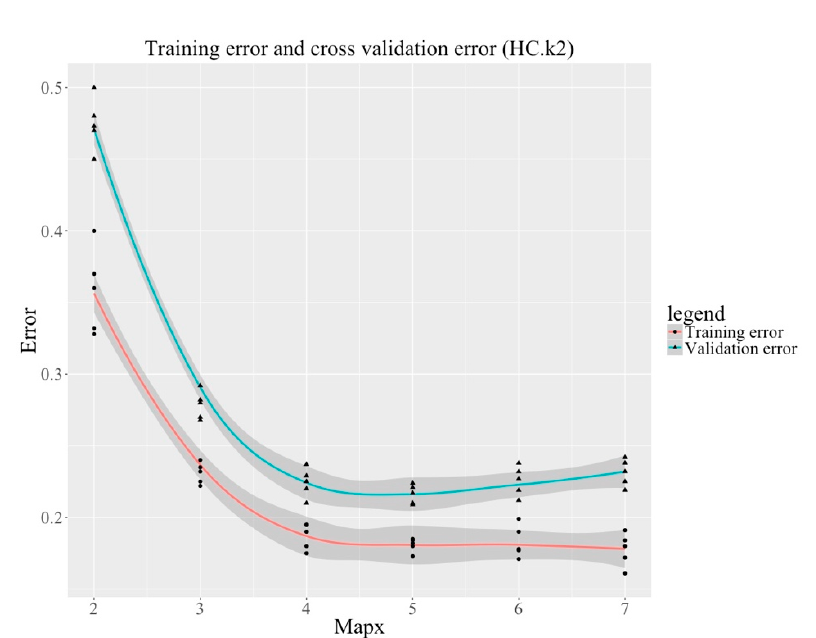
Figure 4. The training error and cross-validation error using the structure search algorithm with HC, the score function with k2, the parameter learning algorithm with Bayesian posterior probability estimation.